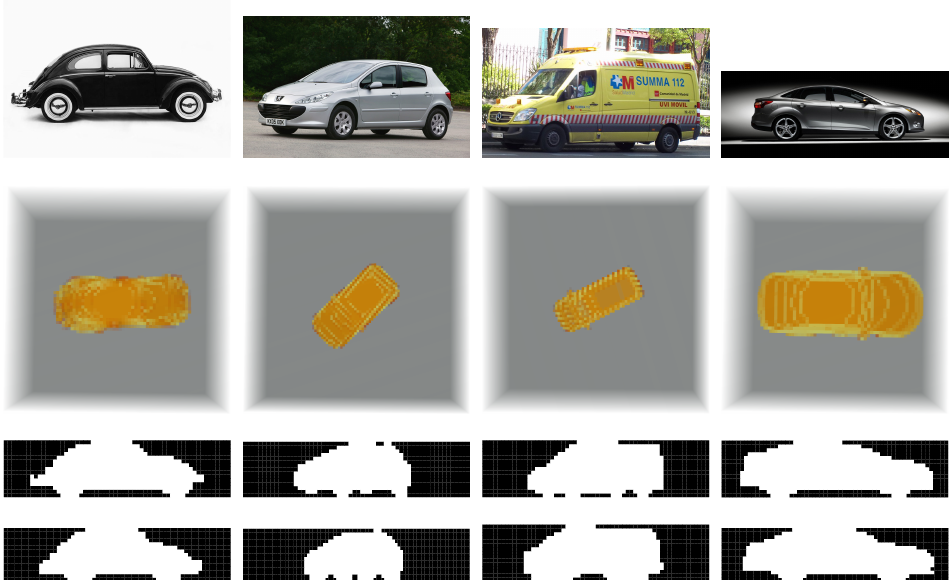
Figure 6. Results of tests on real images. In the first row, the original images as downloaded from the Internet. Second row, 3D objects rotated in the estimated angle and seen from above. Third row, projections after manually segmenting, centering and reducing the scale to 15 × 60 pixels. Fourth row, projections generated applying the estimated rotation angle to the 3D model in the